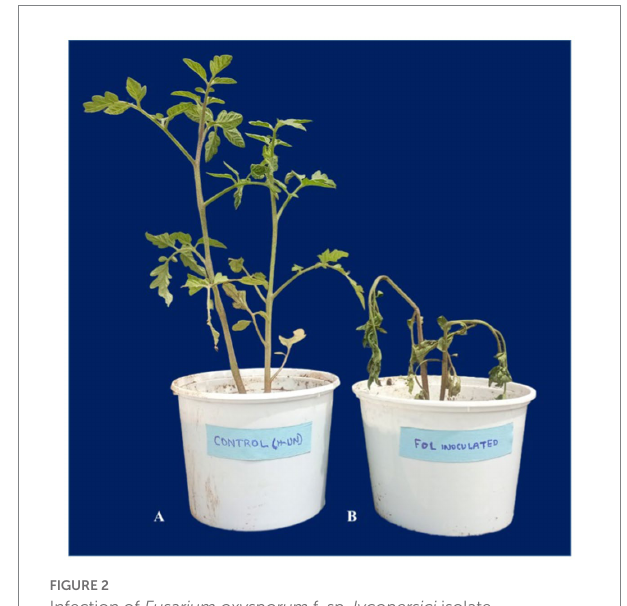
FIGURE 2 Infection of Fusarium oxysporum f. sp. lycopersici isolate. (A) Control; (B) Diseased.